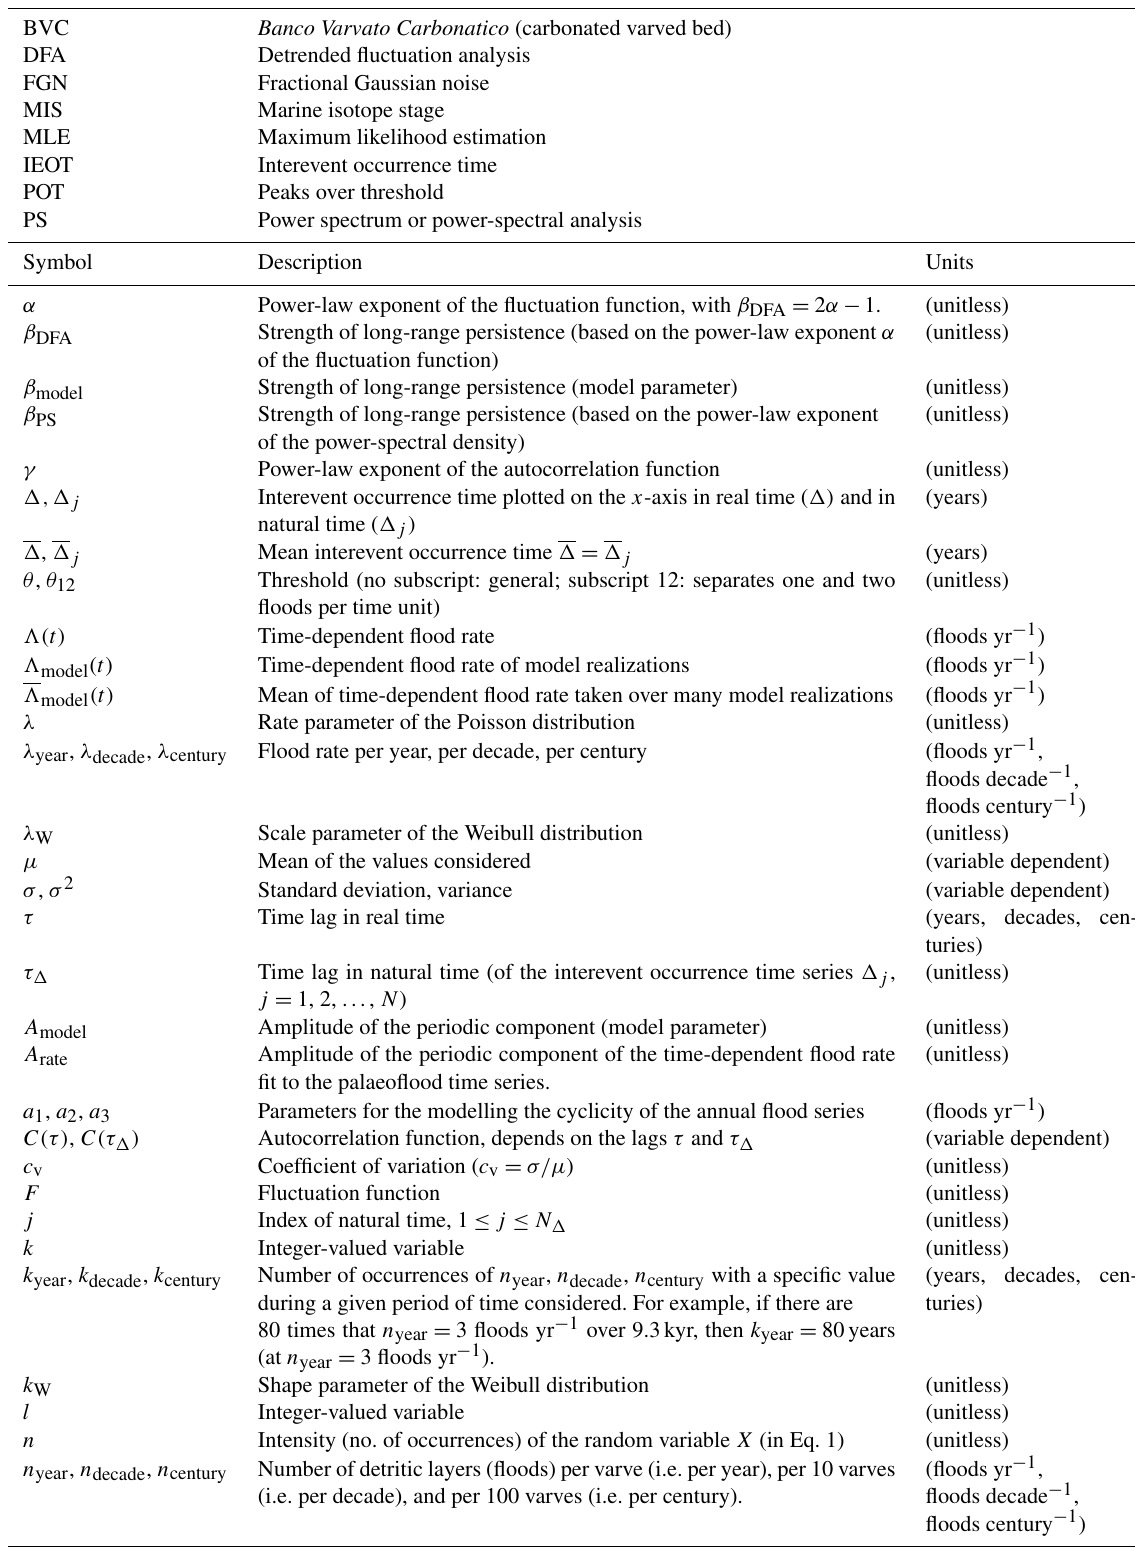
Table 1. Abbreviations and